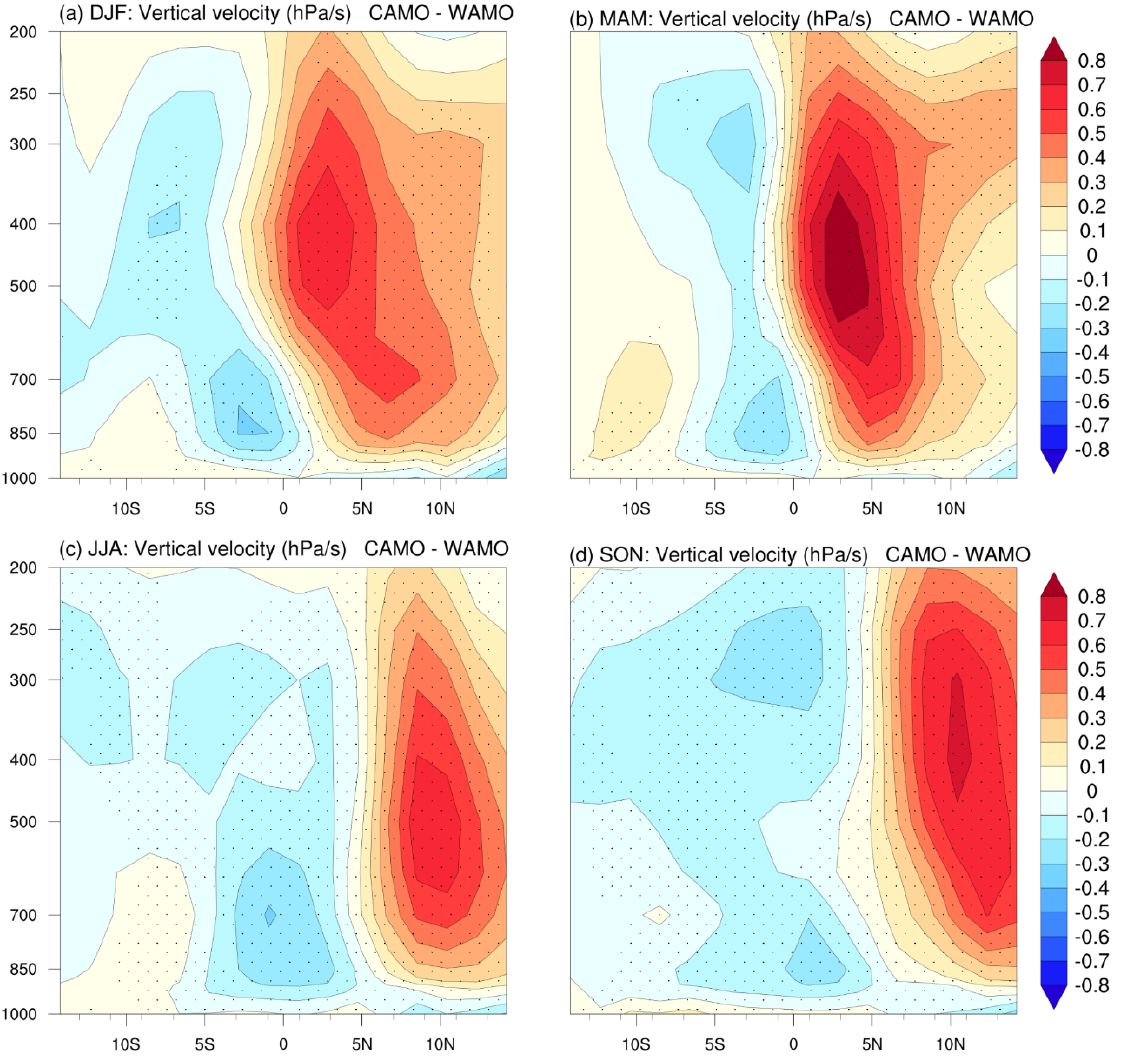
Figure 8. Difference between CAMO and WAMO of vertical pressure velocity (omega; hPa/s) representing the regional Hadley circulation: the latitude – height Section 15° N – 15° S, zonally averaged over 80° W – 30° W, for ( a ) December – February (DJF), ( b ) March – May (MAM), ( c ) June – August (JJA), and ( d ) September –November (SON). Stippled areas represent statistically significant (Student’s t test at 95%) differences.